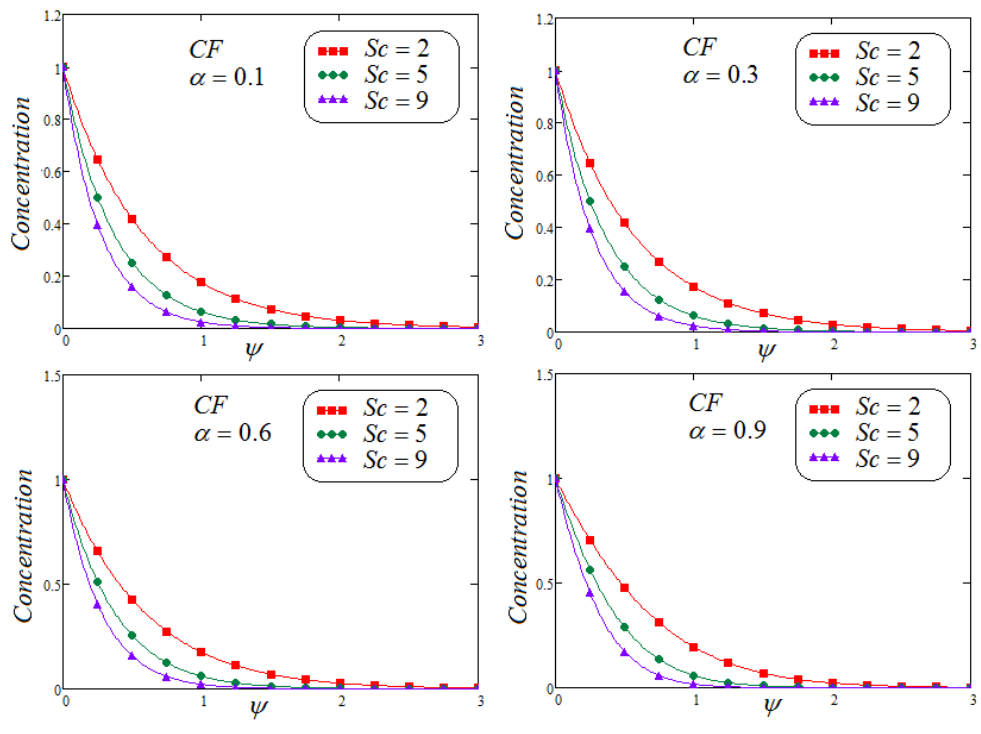
Figure 3. Trace of dimensionless concentration for dissimilar values of Sc via CF.